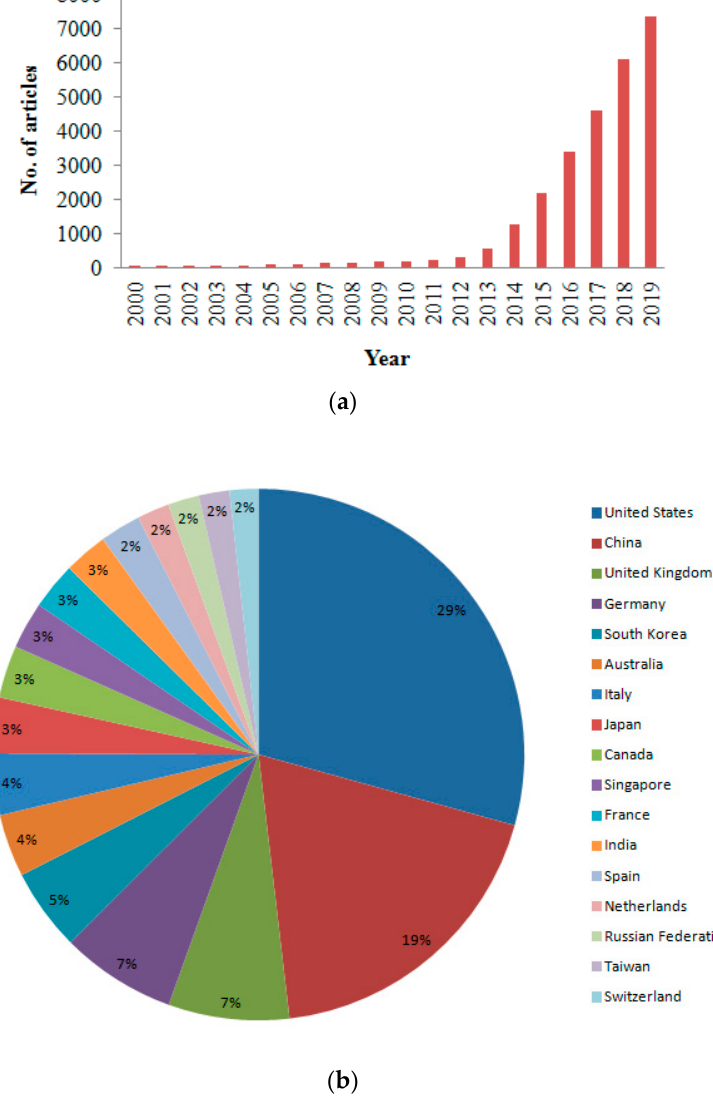
Figure 2. ( a ) Global scientific trends in additive manufacturing: a summary of the year-wise publications of research articles that are indexed in Scopus database. ( b ) Geographical distribution of patents on additive manufacturing as per Scopus database .